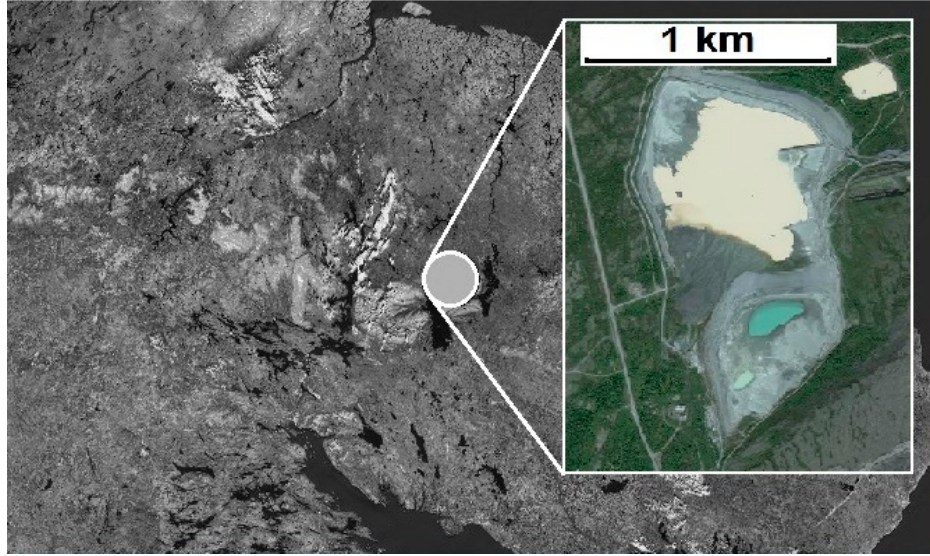
Figure 1. Tailings pond.